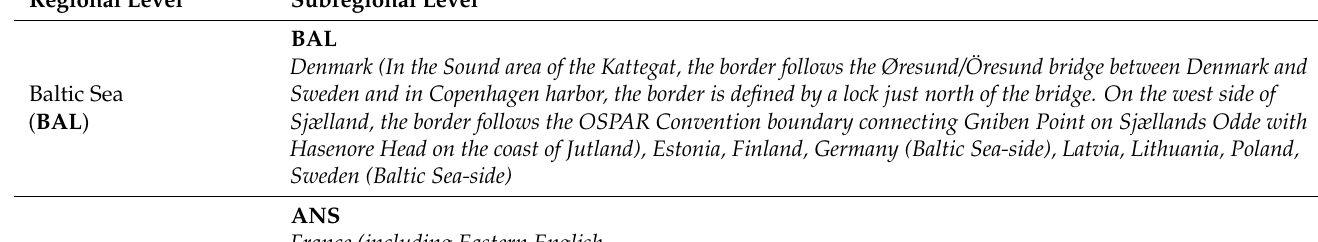
Table 1. Geographic coverage of new NIS introductions in the present study at regional and sub- regional levels. Abbreviation: ABI = Bay of Biscay and the Iberian Coast, ACS = Celtic Seas, ANS = Greater North Sea, AMA = Macaronesia, MWE = Western Mediterranean Sea, MIC = Ionian Sea and the Central Mediterranean Sea, MAD = Adriatic Sea, MAL = Aegean-Levantine Sea (Eastern Mediterranean